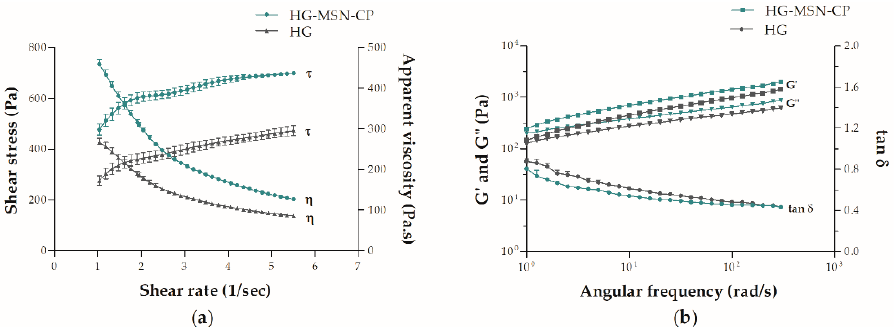
Figure 6. Rheological behaviour of the following printing inks: HG-MSN-CP and HG-CP. ( a ) Flow curves are shown as shear stress ( τ ) and apparent viscosity ( η ) versus shear rate, and ( b ) Oscillatory frequency test demonstrated as storage modulus (G’), loss modulus (G”) and tangent delta (tan δ ) versus angular frequency. Values are presented as mean ± SD ( n = 3).